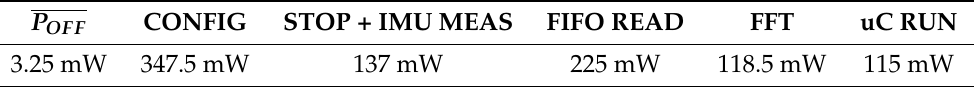
Table 4. Average power consumption of the events generated in the ST controller power profile.